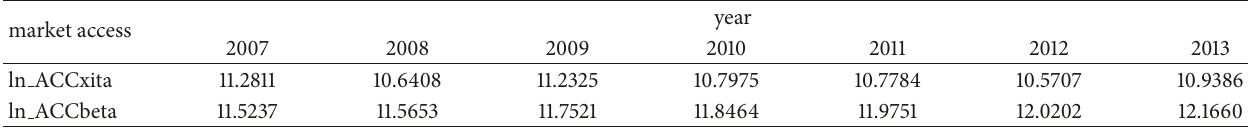
Table 4: The average of the logarithms of market access each